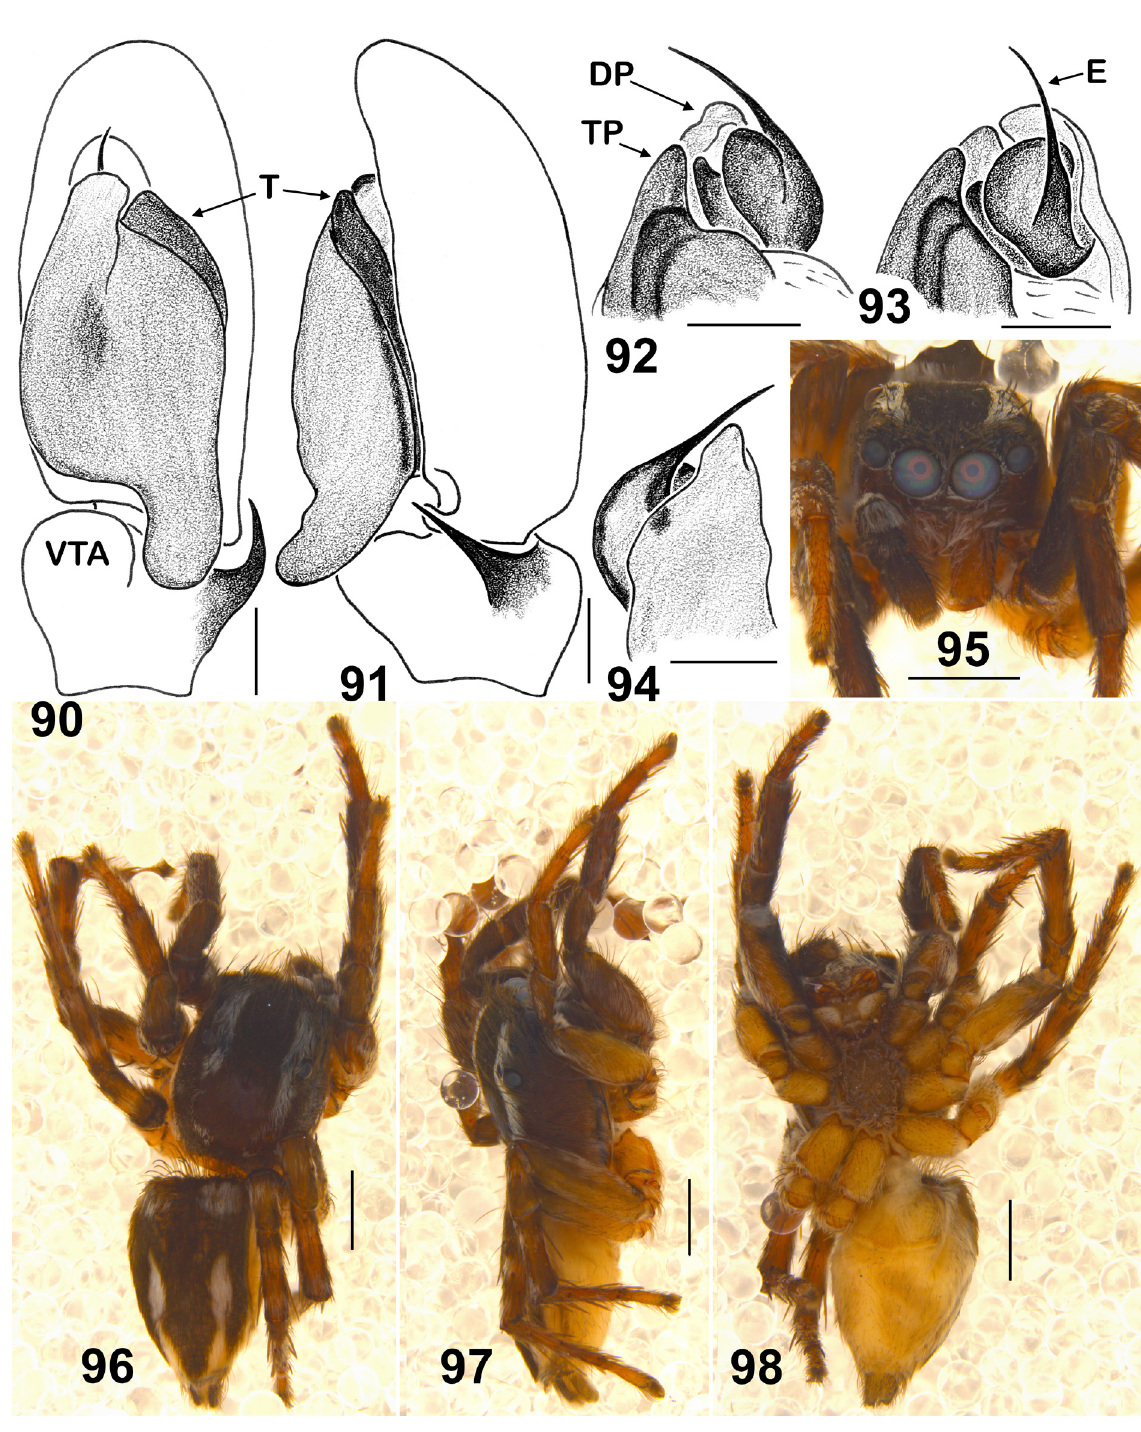
Figs 90–98. Stenaelurillus brandbergensis (Wesołowska, 2006), paratype, ♂ from Namibia (MRAC 216.021). 90 . Palp, ventral view. 91 . Palp, retrolateral view. 92 . Embolic division, retrolateral view. 93 . Embolic division, dorsal view. 94 . Embolic division, median view. 95–98 . General appearance. Abbreviations: see Material and methods. Scale bars: 90–94 = 0.1 mm; 95–98 = 1